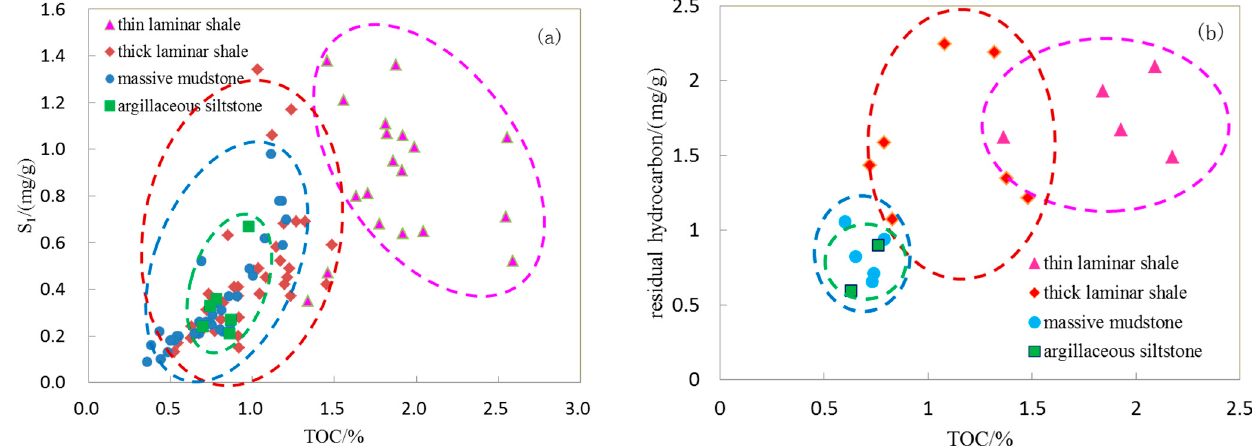
Figure 11. Distribution of residual hydrocarbon content in different shale lithofacies of Es3. ( a ) Py- rolysis S1 of mud shale with different lithofacies; ( b ) residual hydrocarbon of extraction in mud shale with different